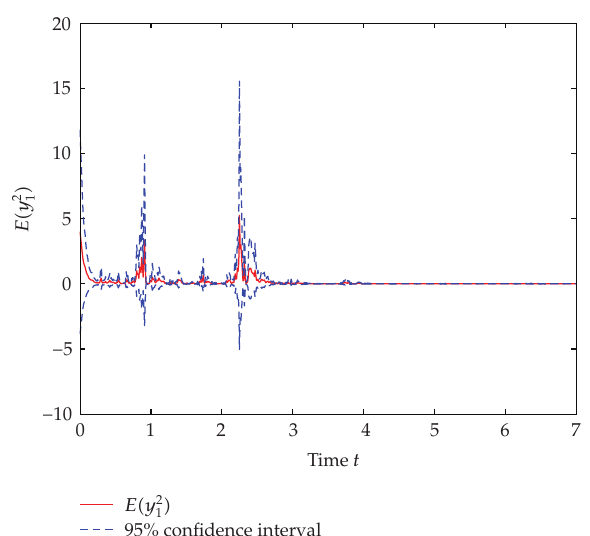
Figure 3: Numerical simulation for the mean square of y 1 (cid:3) t (cid:4)